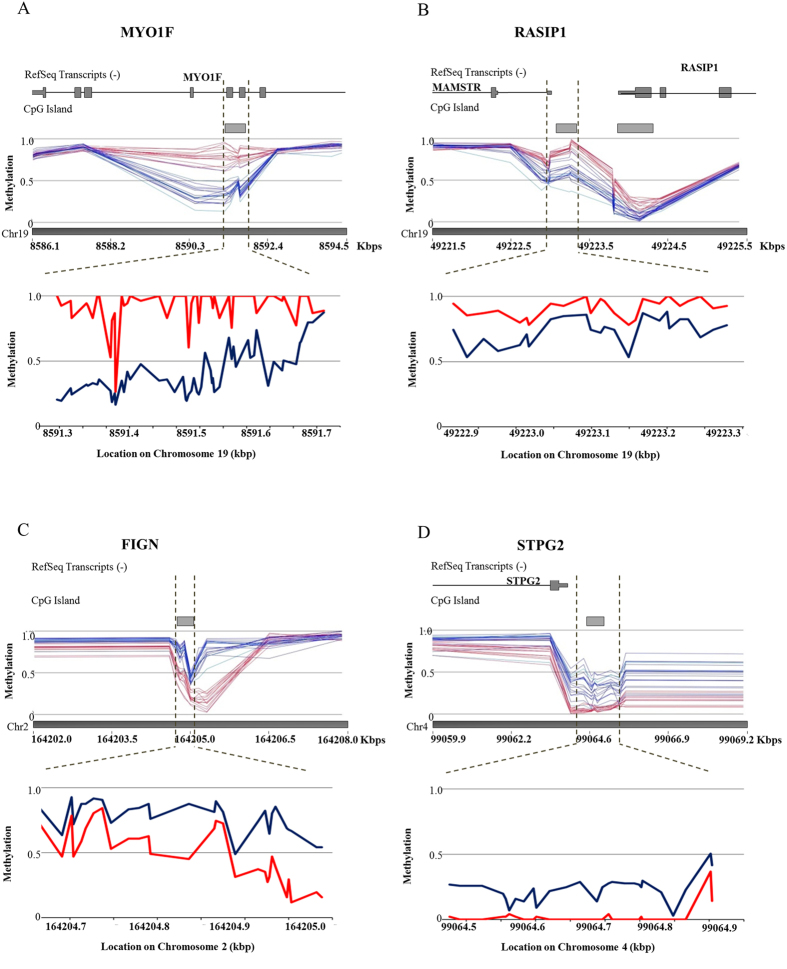
DNA methylation profiles in FHS.Methylation level from 0 (not methylated) to 1 (100% methylated) is shown across regions with significantly altered methylation in FHS: hypermethylated regions (a) MYO1F and (b) RASIP1; and hypomethylated regions (c) FIGN and (d) STPG2. RefSeq genes and CpG islands tracks are annotated on top of the figures. The top image corresponds to methylation array data visualized using Genomic Browser Viewer (Partek). Red lines correspond to representative control sample data. Blue lines correspond to FHS individual data. The bottom image corresponds to average methylation based on bisulfite sequencing data. The red and blue lines indicate the average methylation for control and FHS patient sample, respectively. Dotted lines correlate chromosome location between top (array generated) and bottom (bisulfite sequence generated) images.